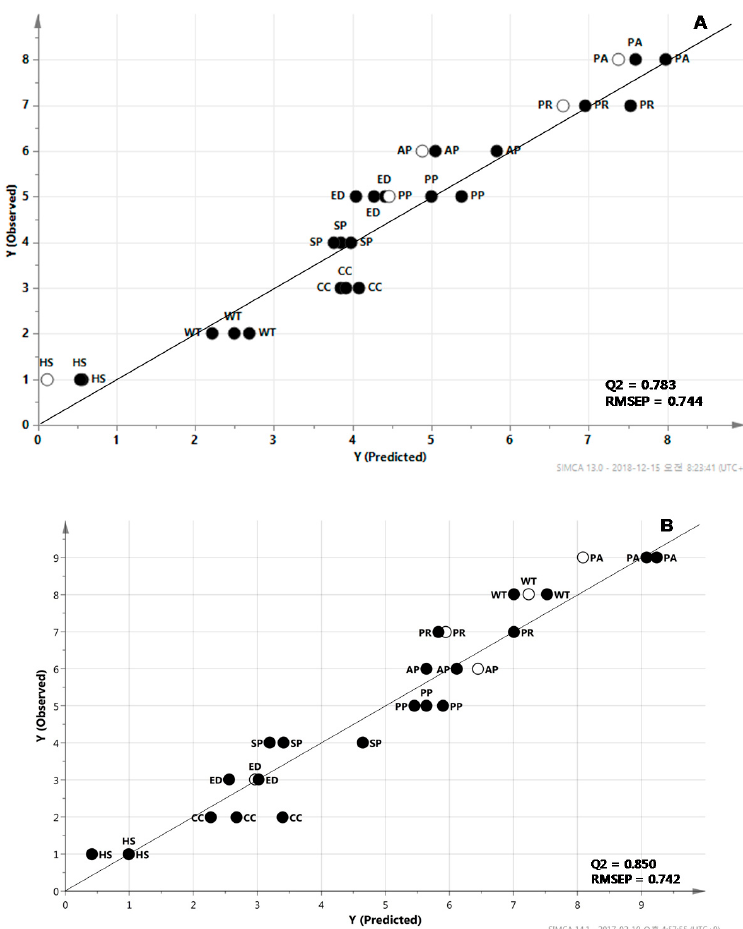
. Figure 5. The partial least squares (PLS) predictive models constructed from the nine Mentha spp. as a training set (filled circle) for predicting the ranking of DPPH free radical scavenging activity ( A ) and reducing power ( B ) based on metabolite profiles from the Mentha samples. A predicted result after five samples of test sets (open circle) was projected on to the model. AP, apple mint; CC, chocolate mint; ED, eau de cologne mint; HS, horse mint; PP, peppermint; PR, pennyroyal mint; PA,